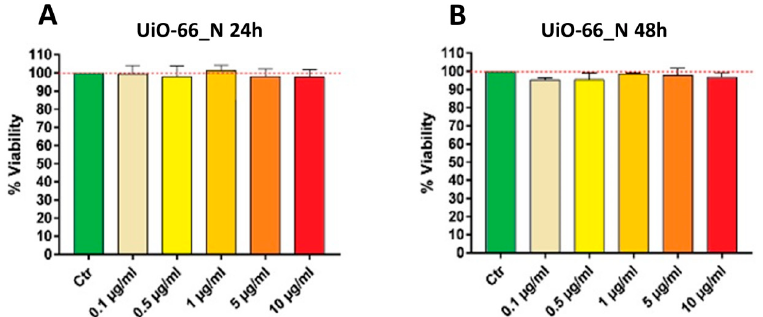
Figure 5. U251 cells viability by MTT assay, after 24 ( A ) and 48 ( B ) hours of incubation with UiO-66_N at various concentrations.